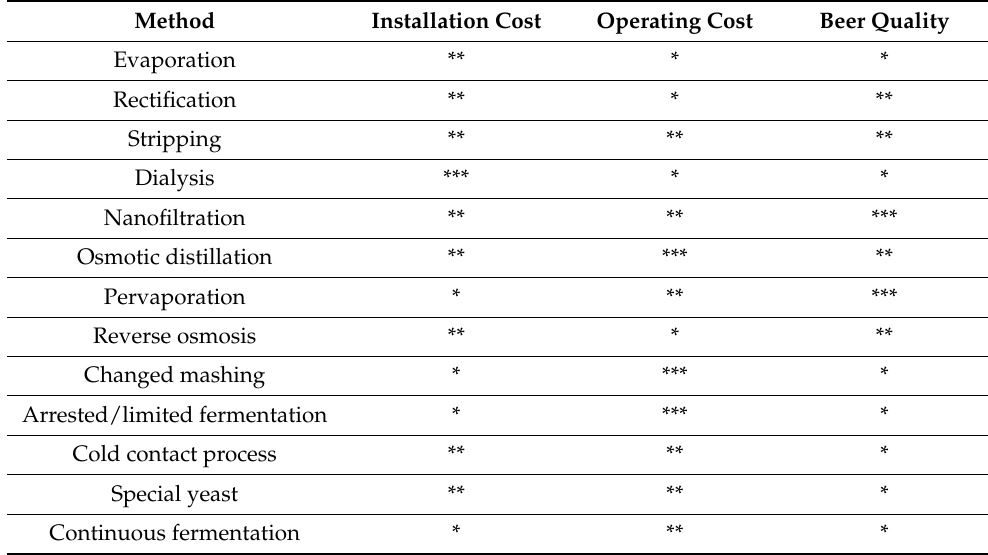
Table 1. Comparison of installation cost, operating cost, and quality of final beer of low-alcohol beer (LAB) and alcohol-free beer (AFB) production methods (based on [10]). Method Installation Cost Operating Cost Beer Quality Evaporation Rectification